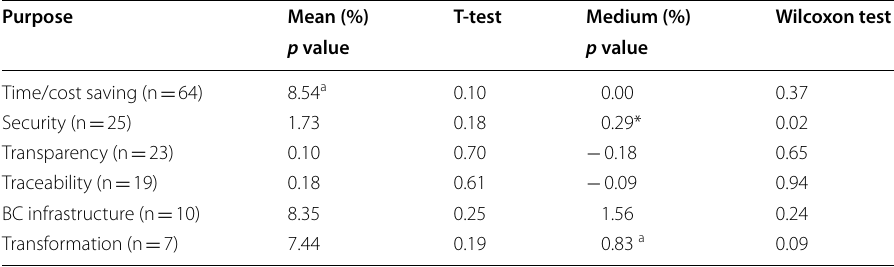
Table 15 Subgroup analysis for all